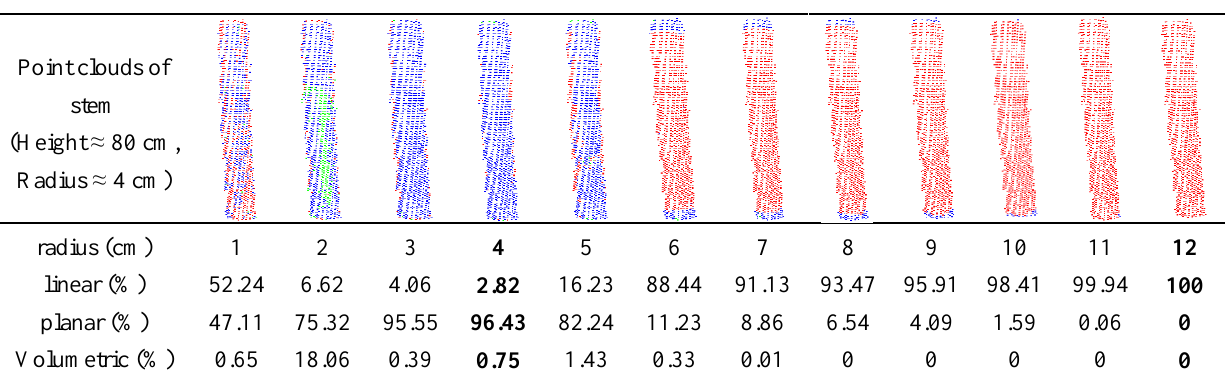
Table 1. Percentages of classified features in sampled stem data.